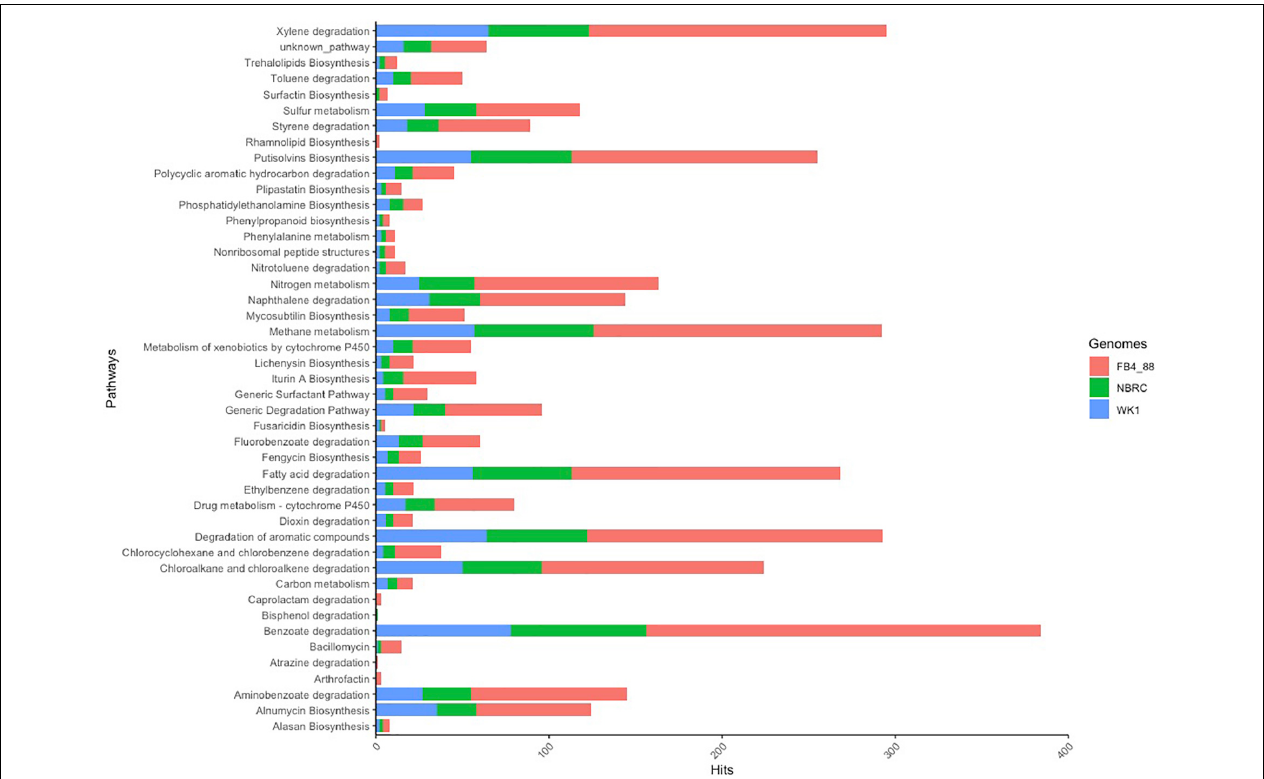
FIGURE 6 | Functional annotation of Anoxybacillus flavithermus strains (NBRC, WK1, and FB4_88) for biodegradation of petroleum hydrocarbons and biosurfactant production. A. flavithermus FB4_88 isolated in this study is represented in